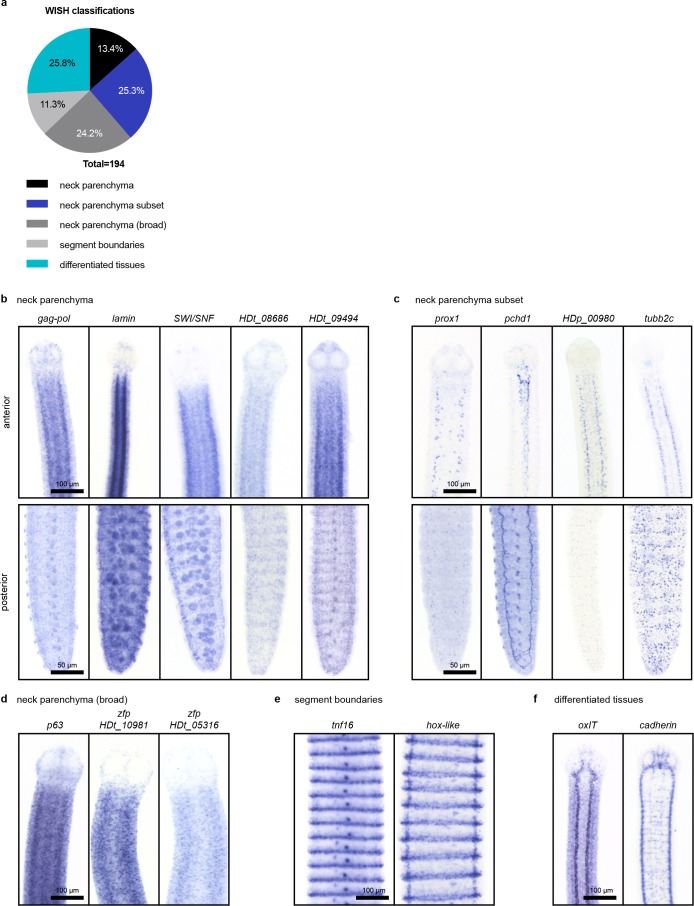
WISH patterns of irradiation-sensitive transcripts identified using RNA-seq.(a) Classification of WISH expression patterns of irradiation-sensitive transcripts. (b–f) Examples of transcripts expressed in the neck parenchyma (b) in subsets of cells within the neck (c) in neck parenchyma and broadly toward the animal edge where differentiated muscle and tegument are located (d) at segment boundaries (e) and in differentiated tissues (f) like the osmoregulatory canals (left) and nervous system (right).